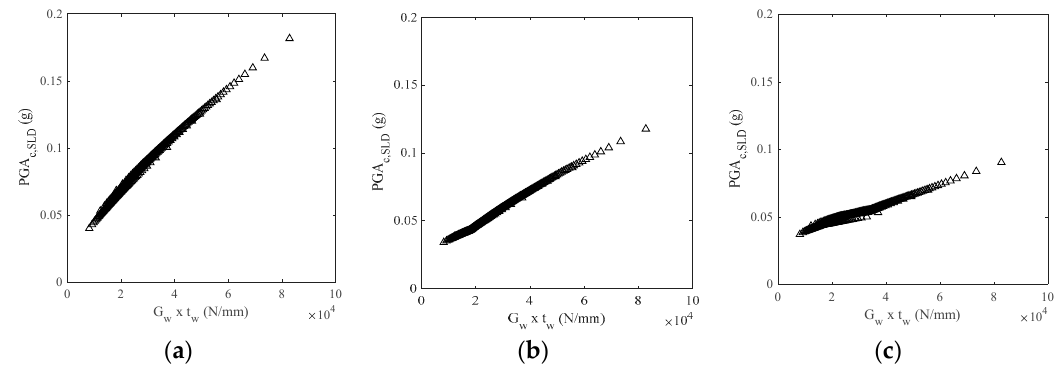
Figure 11. Variation of PGA c,SLD with G w t w for ( a ) three-storey, ( b ) five-storey, and ( c ) seven-storey buildings.